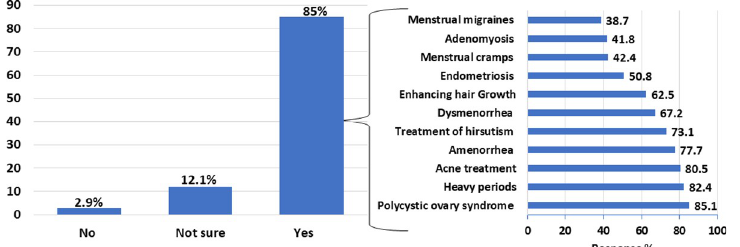
Fig 1. Pharmacists’ knowledge about the presence of non-contraceptive indications for OCPs (n = 380). Among the participants who agreed with the presence of non-contraceptive indications for OCPs (n = 323, 85%), the horizontal column chart demonstrates the chosen indications.